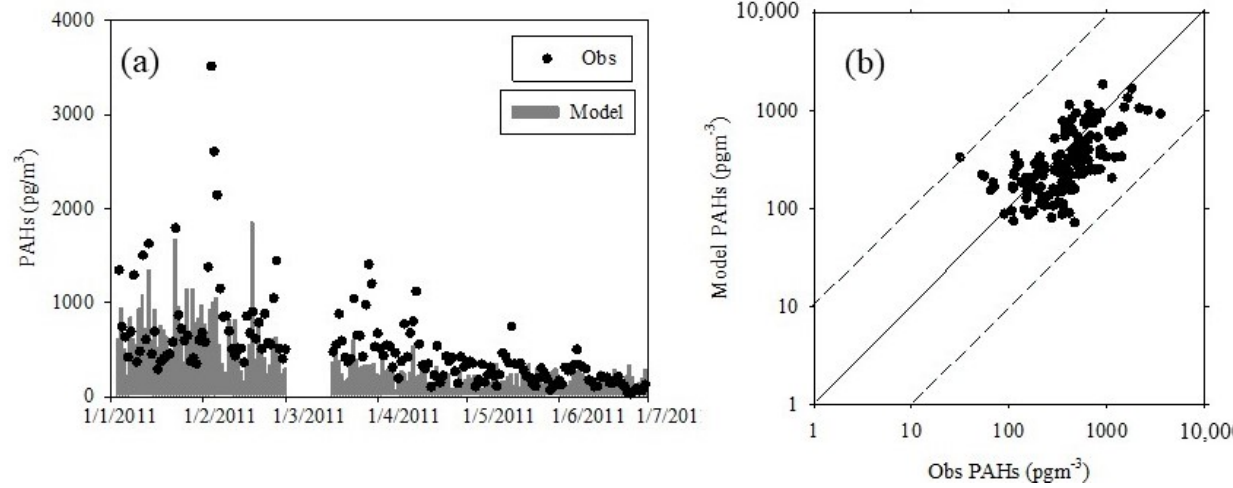
Figure 2. Comparison of the observed and simulated p-PAH concentrations in Kanazawa. ( a ) Temporal variations, ( b ) scatter plot. The straight line indicates the 1:1 relation between the observed and simulated concentrations. The short-dashed line indicates a factor of 10.